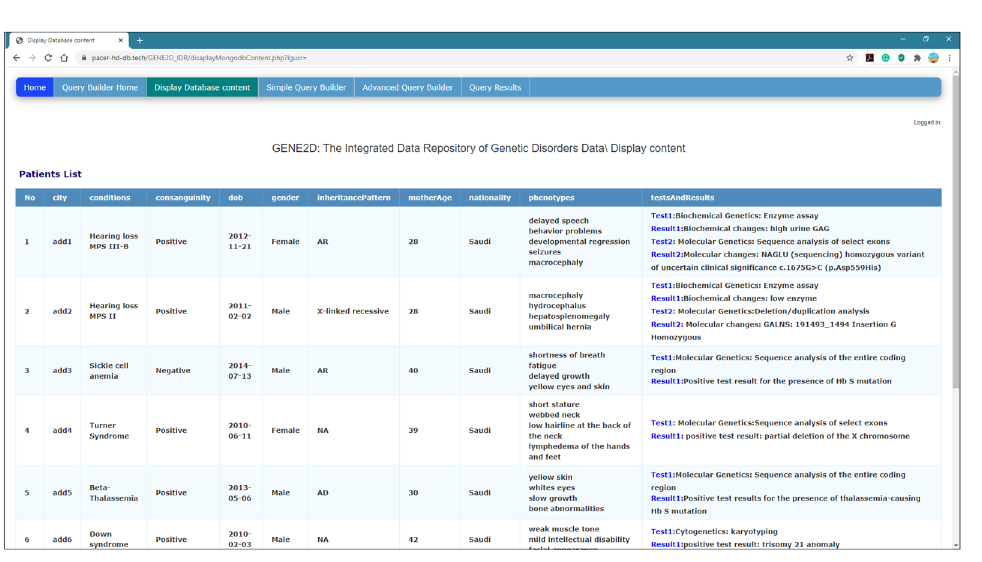
Figure 6. Display of the database content page.